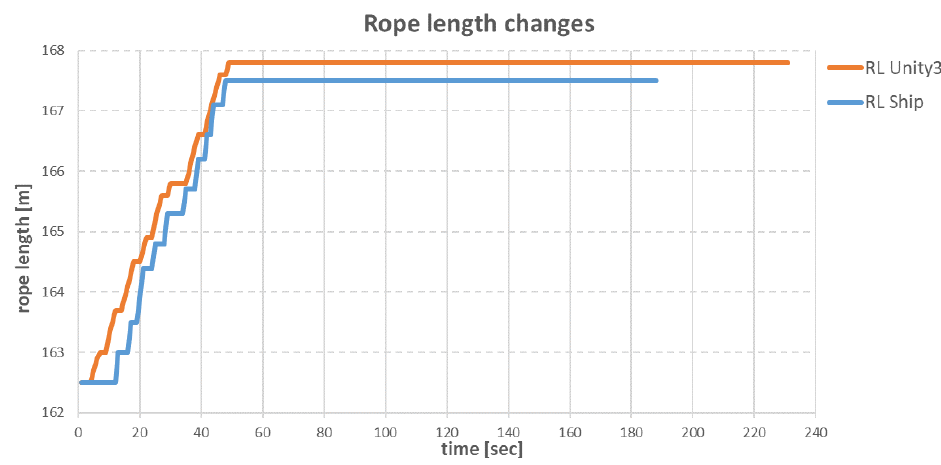
Figure 35. Changes in BS rope lengths over time.